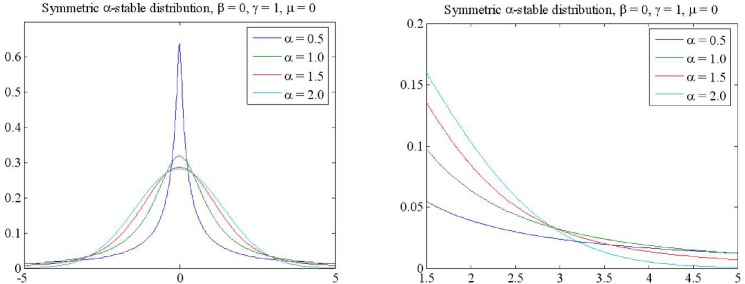
PDFs of SαS stable distribution in different α.